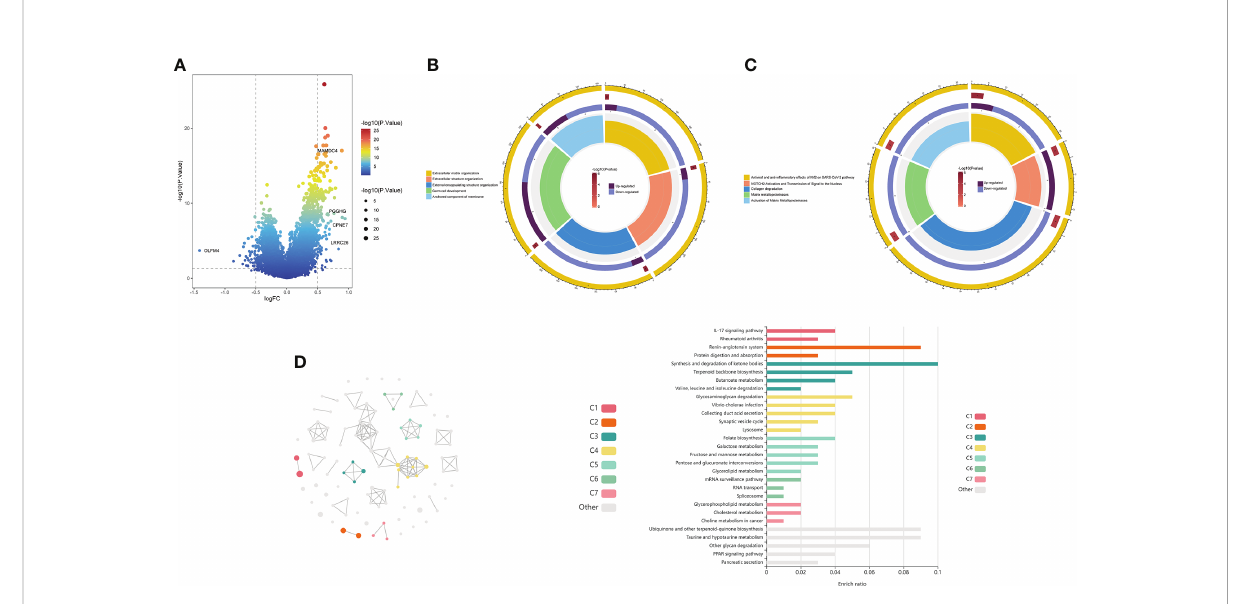
FIGURE 7 Functional enrichment analysis of the choline metabolism-related signature. (A) Volcano plot of DEGs in the high- and low-risk groups. (B) GO analysis of DEGs. (C) KEGG analysis of DEGs. (D) cirFunMap of functional enrichment analysis of DEGs by the KOBAS-i database. The left side shows a circular network view, with different colors representing different clusters. Node sizes represent the P values at eight different levels. The right side shows a bar graph of the enrichment ratio in different cluster